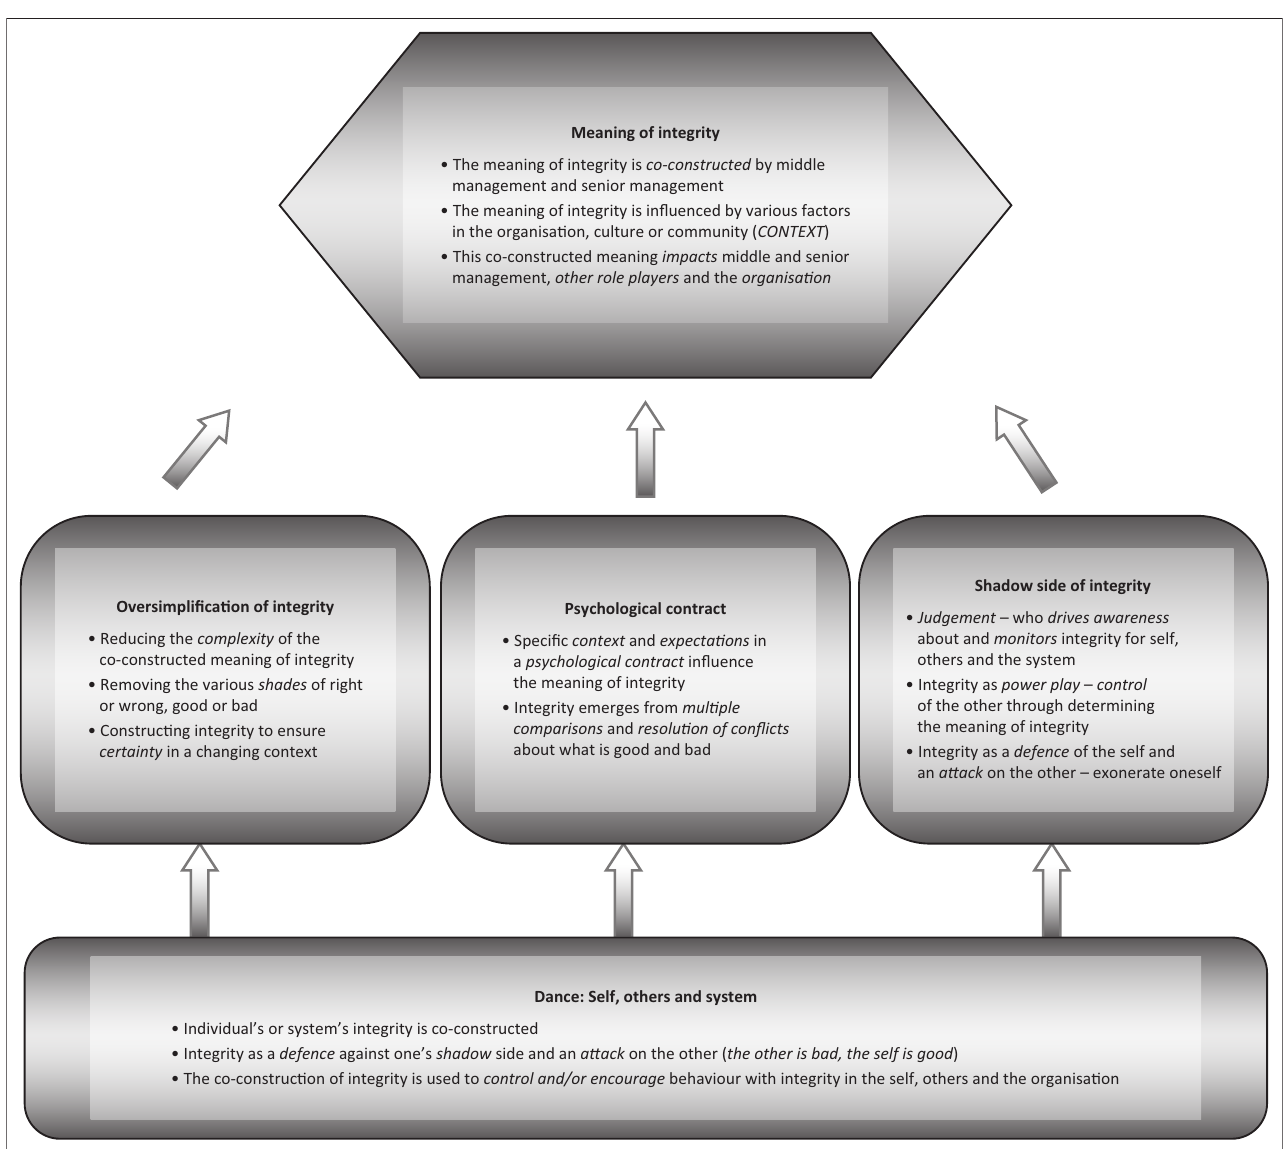
FIGURE 2: Psychology practitioners’ insights into how senior managers can develop middle manager